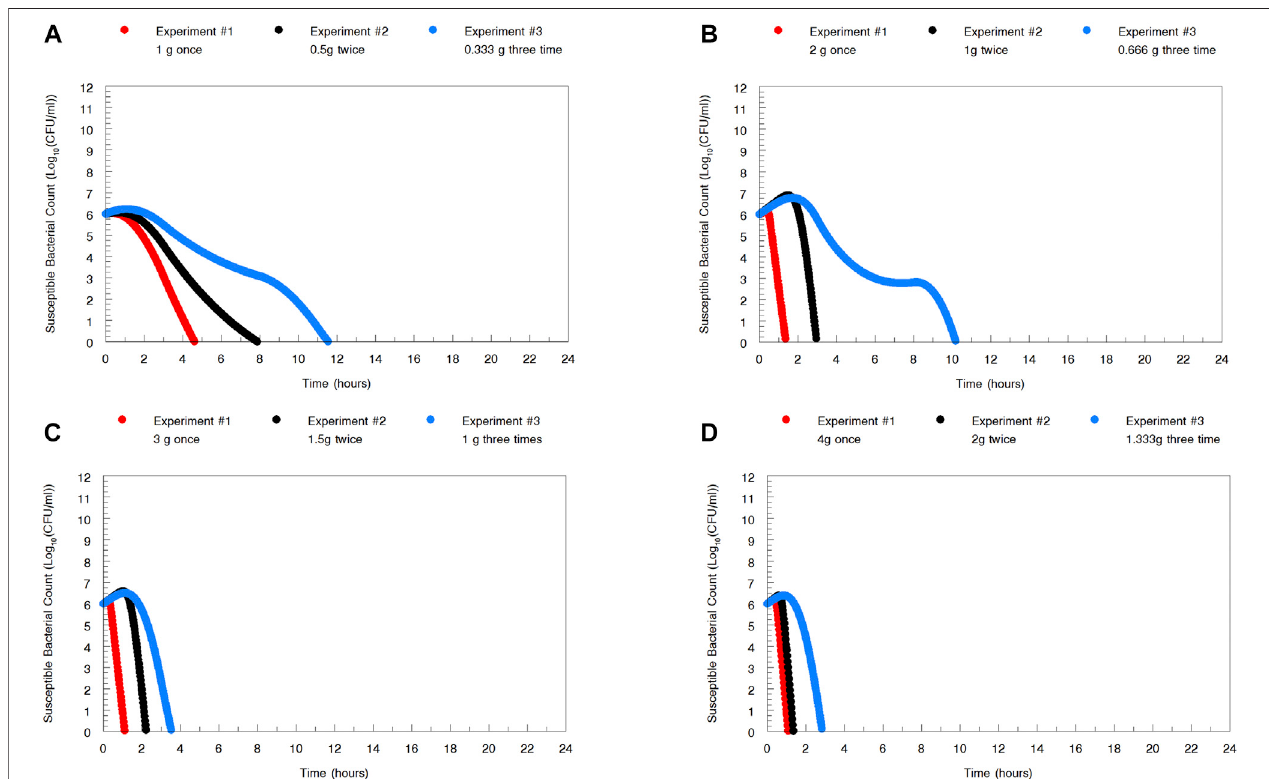
FIGURE 5 | To examine the impact of administration schedule on the rate of Neisseria gonorrhoeae WHO X kill, simulations were performed for the whole zoli fl odacindose administered at once, halfthe dosetwice 12 h apart, and one-third the dose three times 8 h apart. The mostrapid N.gonorrhoeae kill wasobtained by administering the full dose once. However, for larger doses, that is, over 2 g, of zoli fl odacin, the schedule of doses becomes less relevant.